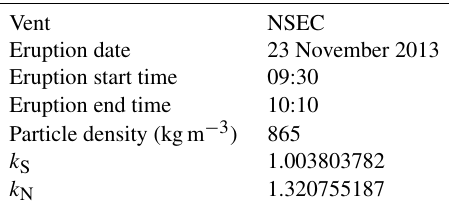
Table B2. Input parameters used to calibrate the model. NSEC: New Southeast Crater. Particle density, k S and k N are median values calcu- lated from field data.